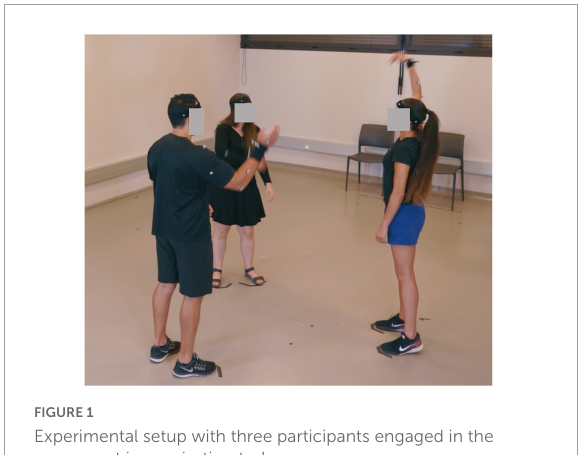
FIGURE1 Experimental setup with three participants engaged in the movement improvisation